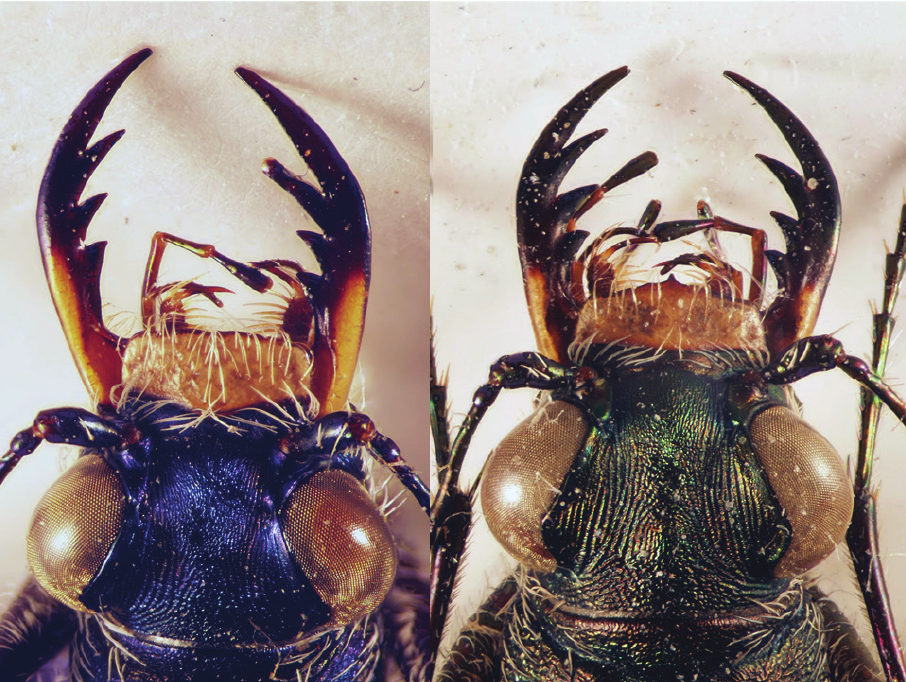
Figure 50. Head of Calomera species in dorsal view: C. diania (left), C. aulica